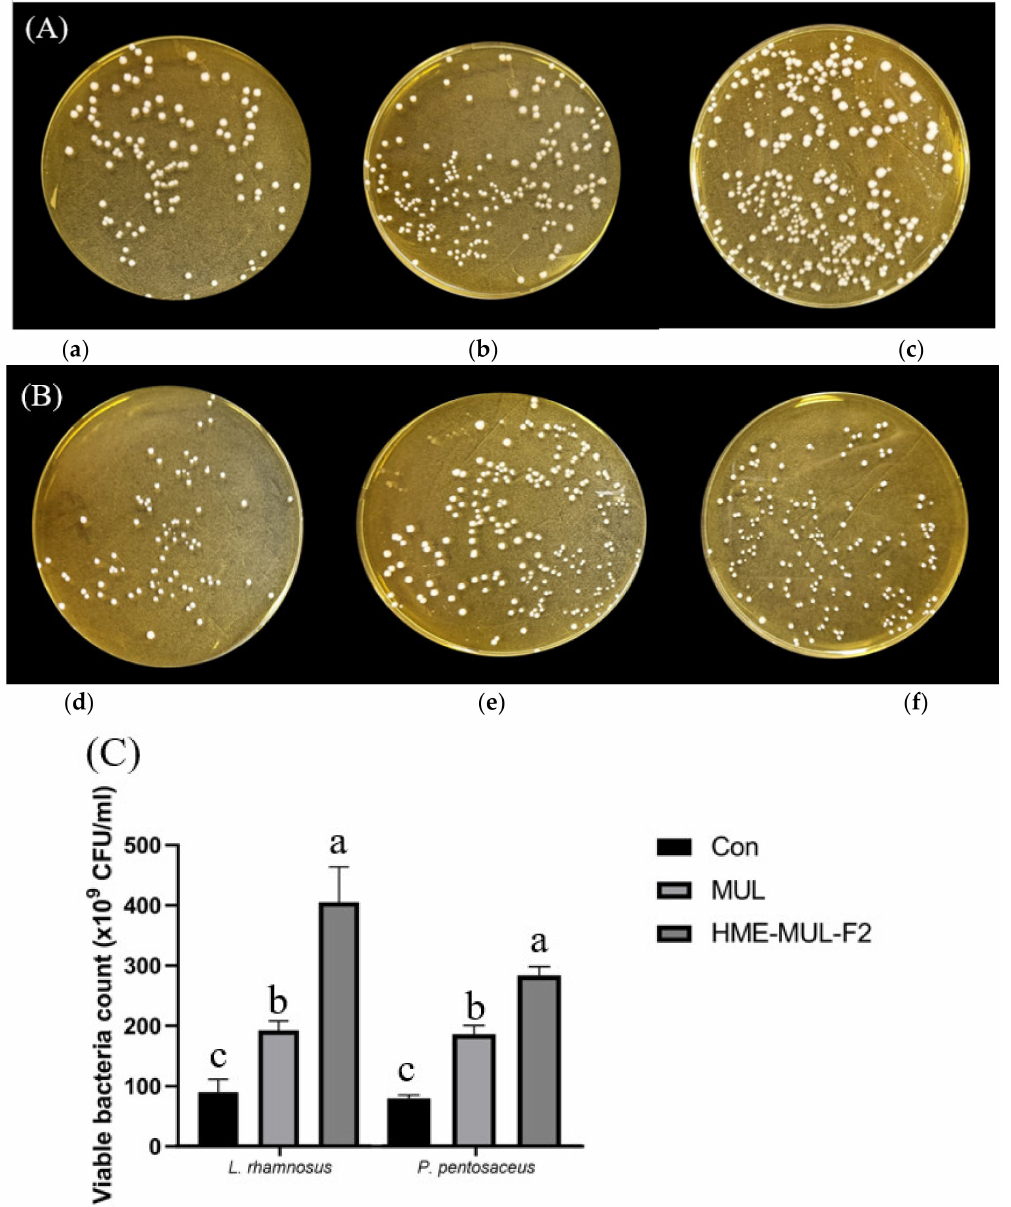
Figure 7. Photos of probiotics colonies co-cultured with mulberry raw materials (MUL) and HME- DDS formulation (HME-MUL-F2). ( A ) L. rhamnosus , ( B ) P. pentosaceus , ( C ) Quantification of probiotics colonies in the presence of MUL and HME-MUL-F2. ( a ) L. rhamnosus , ( b ) L. rhamnosus + MUL (2 mg/mL), ( c ) L. rhamnosus + HME-MUL-F2 (2 mg/mL), ( d ) P. pentosaceus , ( e ) P. pentosaceus +